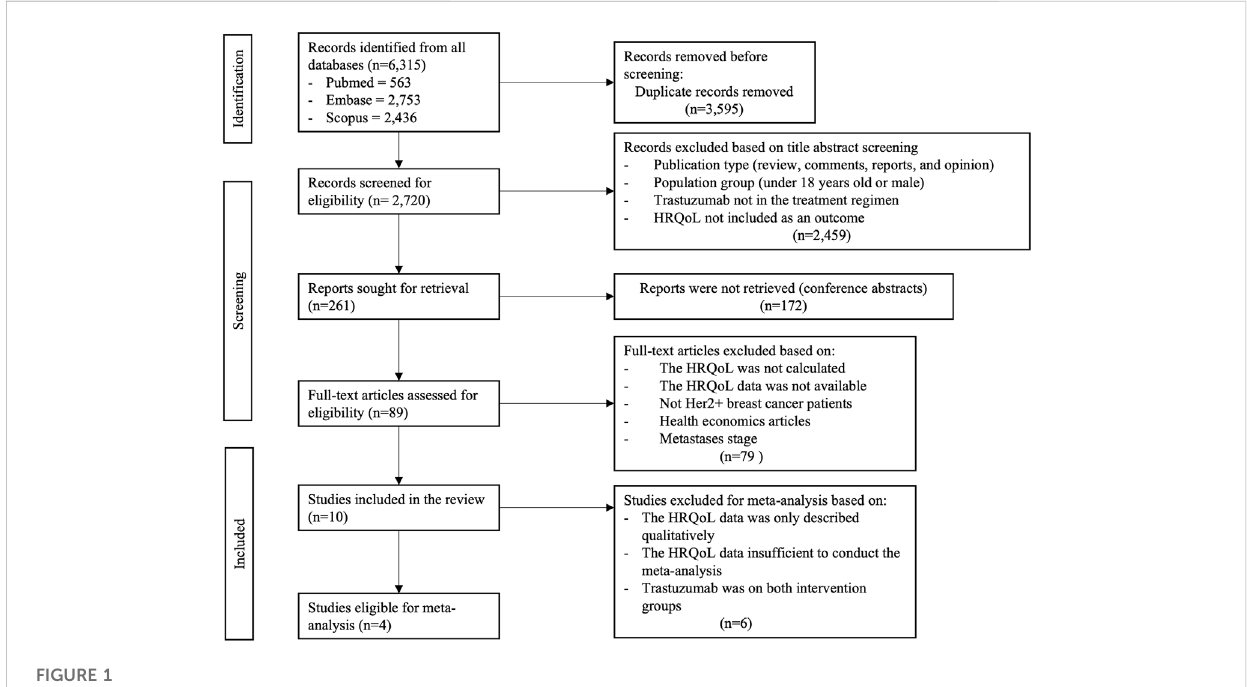
FIGURE 1 Prisma fl ow